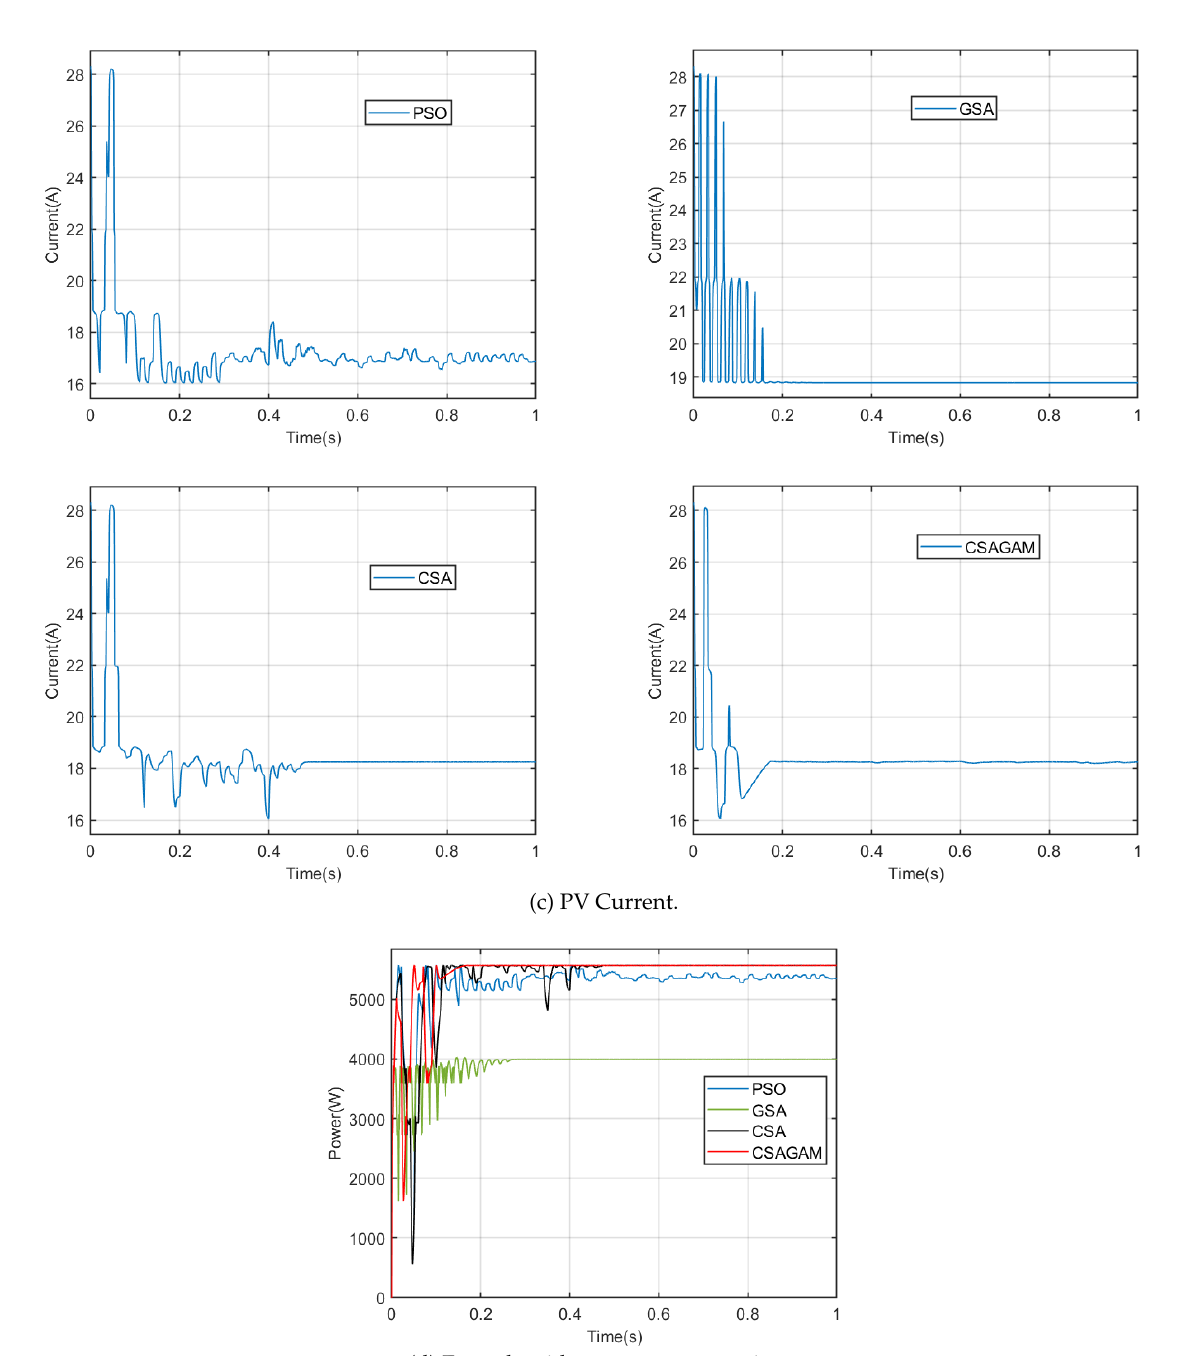
Fig. 6. Simulation results for the first partial shading case PSC 1.